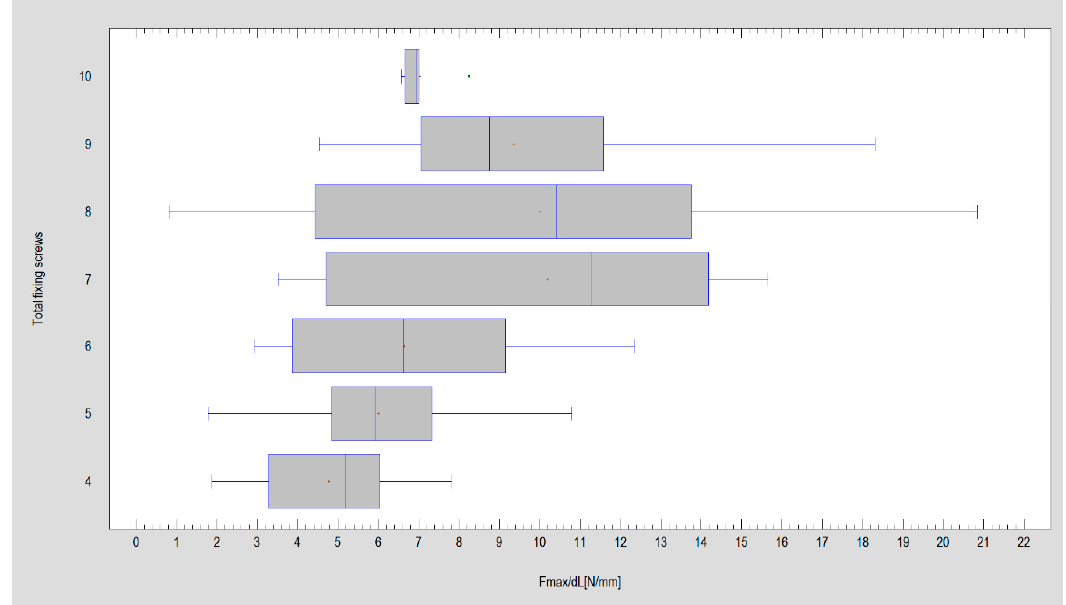
Figure 4. Register results of the amount of required force for one-millimeter displacement in fracture line after plate fixation in view of total number of holes designed in tested plates. The best results for plates with 7–9 holes ( p < 0.05).